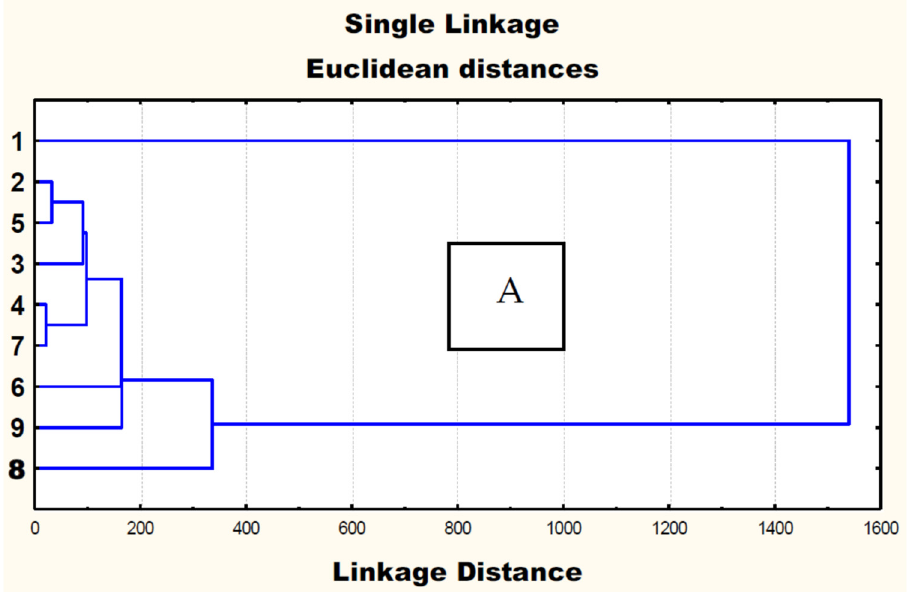
Figure 6. Cluster analysis of the influence of abiotic environmental factors (temperature and humidity of air and soil) on the concentration of radon in indoor air for 2021 campaign. 1—concentration 222 Rn, 2—average air temperature, 3—maximum air temperature, 4—minimum air temperature, 5— average soil temperature, 6—maximum soil temperature, 7—minimum soil temperature, 8—aver- age air humidity, 9—minimum air humidity.